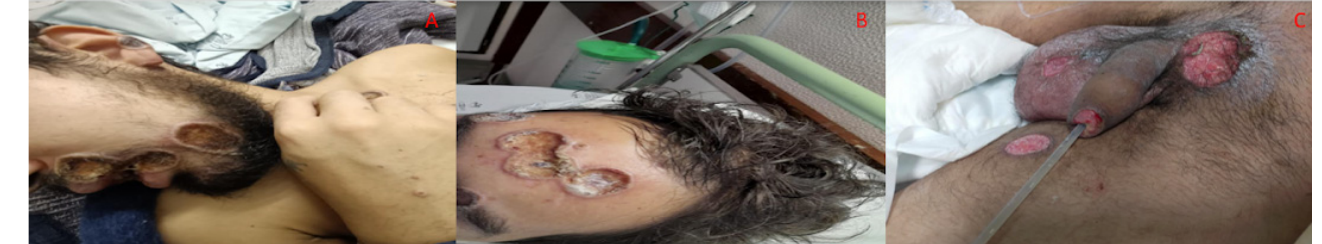
Figure 1. Clinical and imaging pictures of the case. ( A – C ) Pictures of perioral, frontal, and genital lesions at the beginning of hospitalization (day +9).